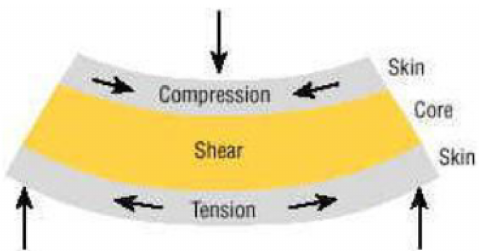
Figure 4: Plate sandwich